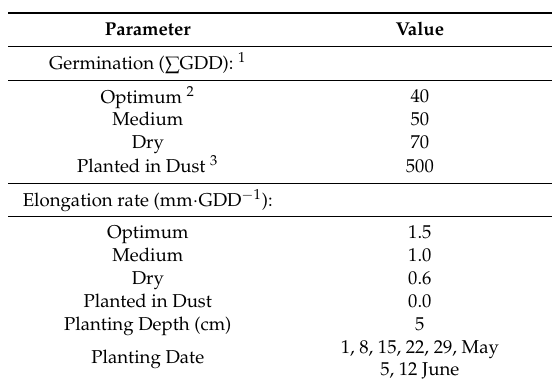
Table 5. Sorghum default parameters for seedling